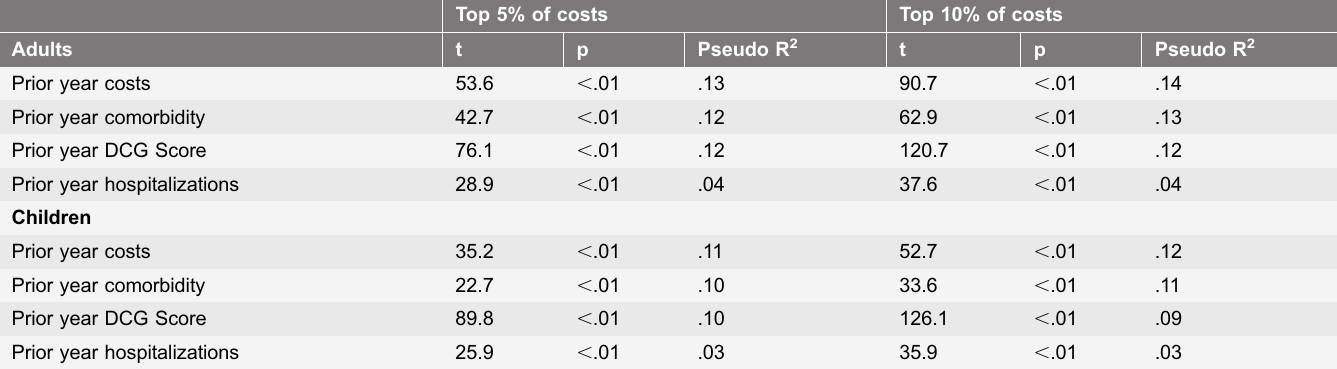
Table 5. Predictors of the adults and children who would have the top 5% and 10% of subsequent (2010) costs using quantile regression. Top 5% of costs Top 10% of